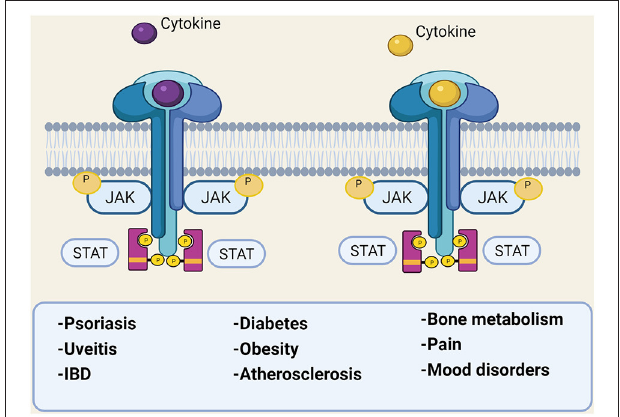
FIGURE 2 | The JAK/STAT pathway involvement in different diseases. IBD, inflammatory bowel disease; JAK, Janus kinase; P, phosphate; STAT, signal transducer and activator of transcription. Created with Biorender.com